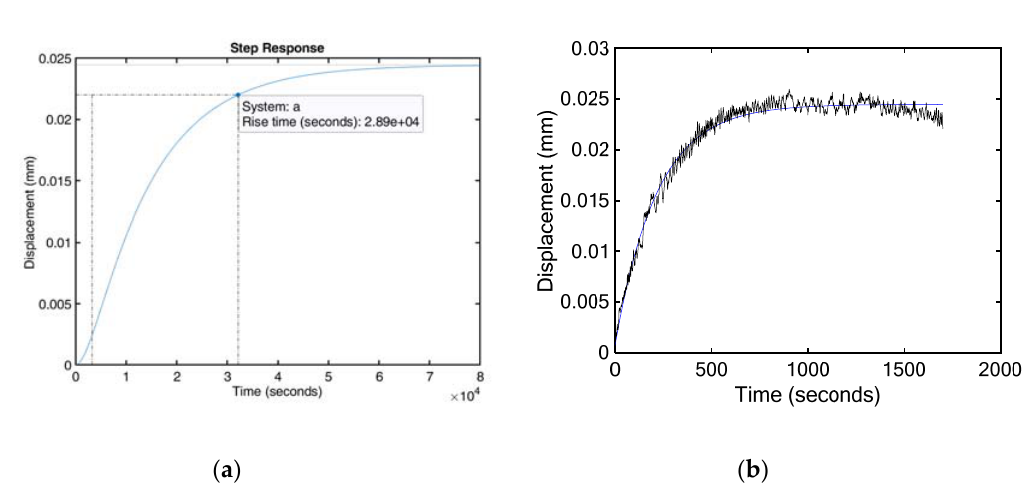
Figure 7. ( a ) The rise time, which is 10% to 90% of the final value. Ten percent to 90% was used as the final rise time value of the model, and the other 90% was stable time. ( b ) The fit diagram of the system identification and actual displacement; the two-order system fits the actual displacement value very well.